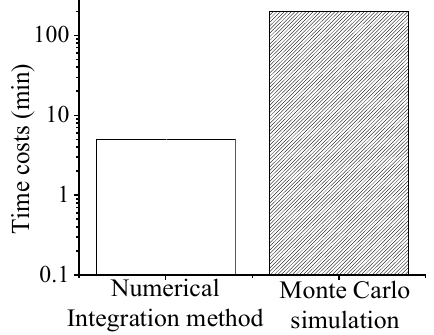
Figure 12. Comparison of the time costs of different methods.